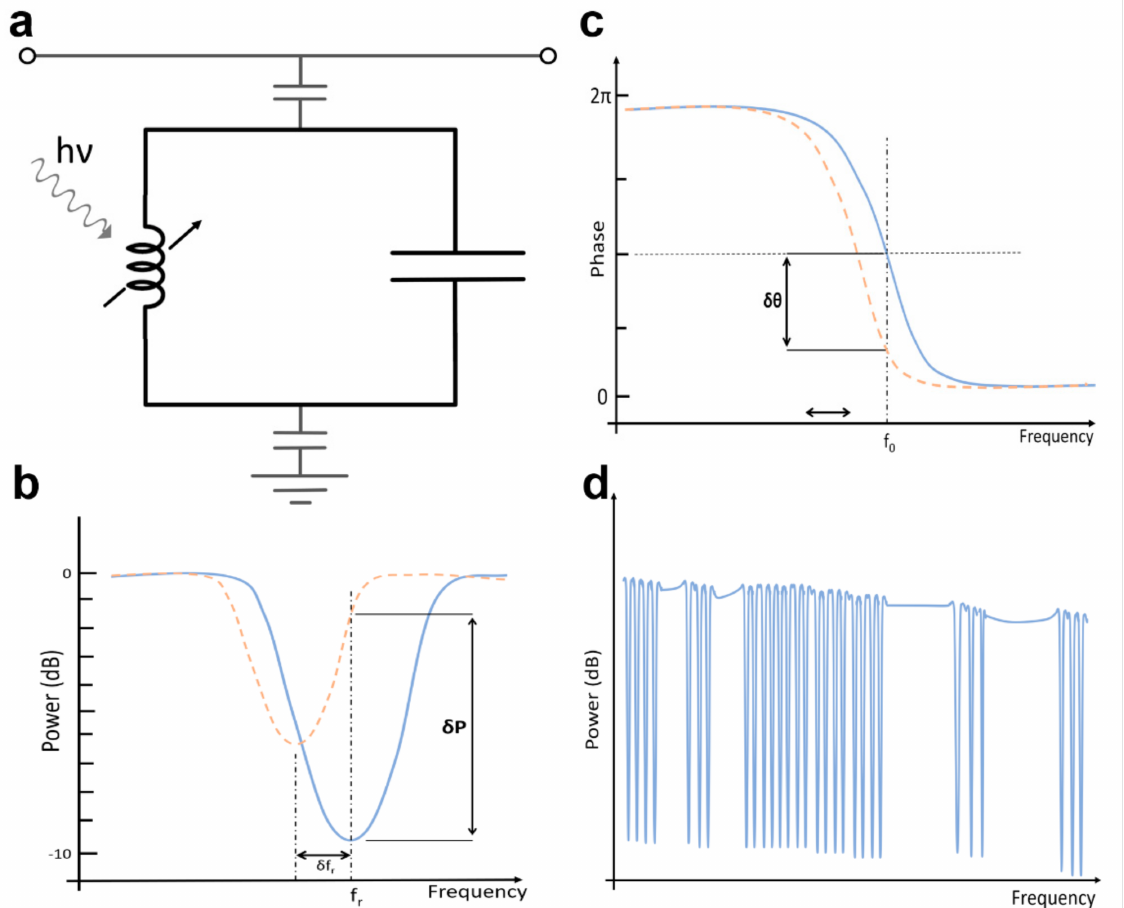
Figure 1. MKID operation principle. ( a ) LC resonant circuit; ( b ) amplitude of transmitted feedline signal before (blue) and after (red) photon absorption; ( c ) feedline signal phase response; ( d ) several resonators multiplexed with a single feedline. At resonance the LC circuit is effectively shorting the capacitively coupled microwave feedline to ground, resulting in a sharp dip in transmitted